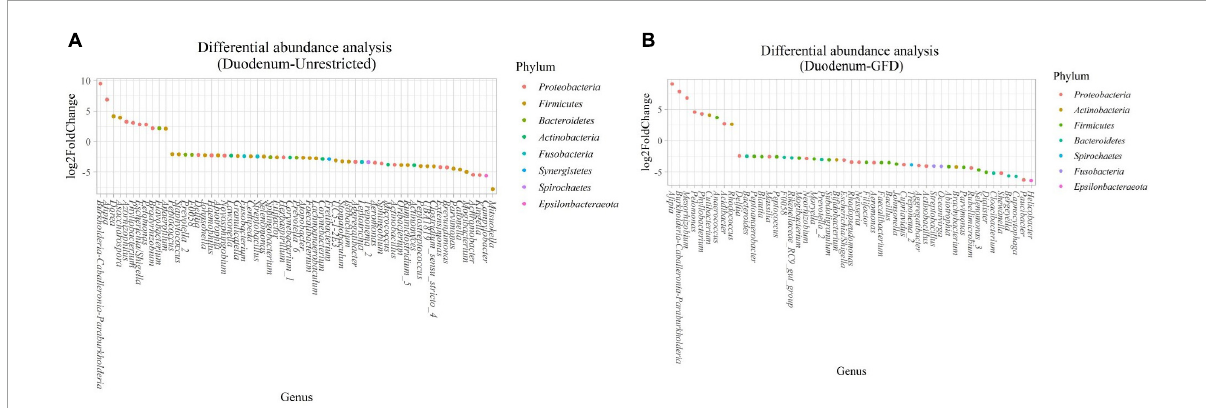
FIGURE4 Differential abundance analysis performed on samples from the duodenum of Patients with CeD following an unrestricted diet (A) and Patients with CeD under a GFD (B) compared with healthy